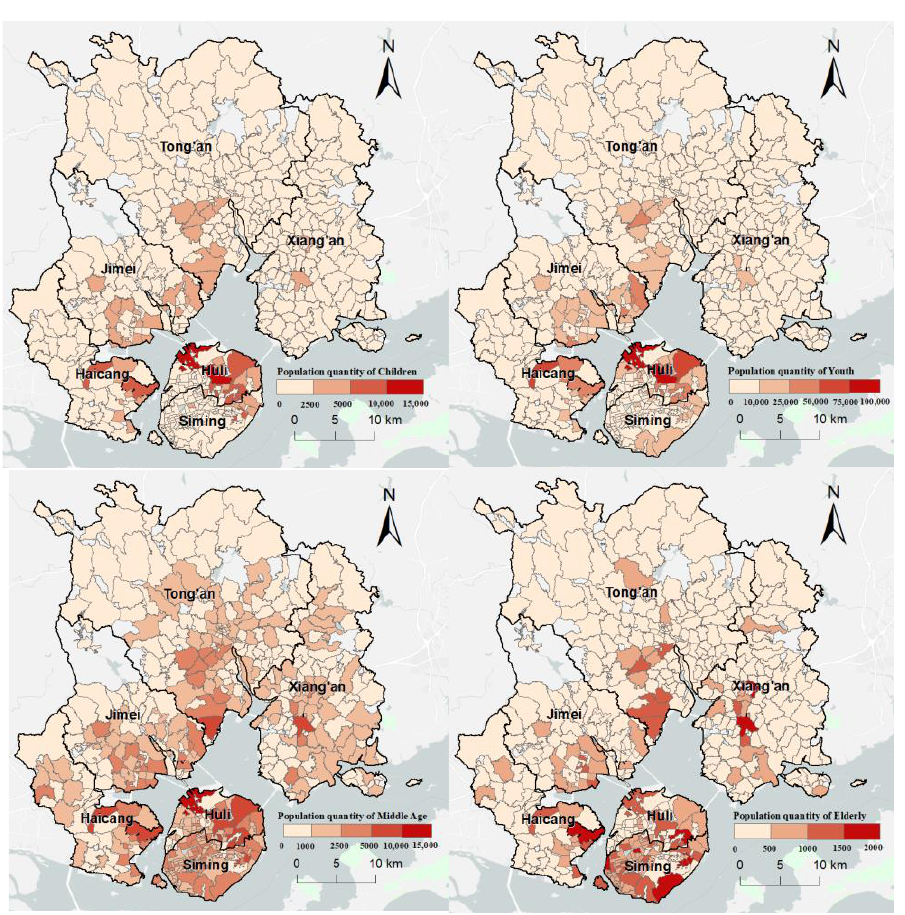
Figure 3. Spatial distribution of different age groups at the community scale in Xiamen City.